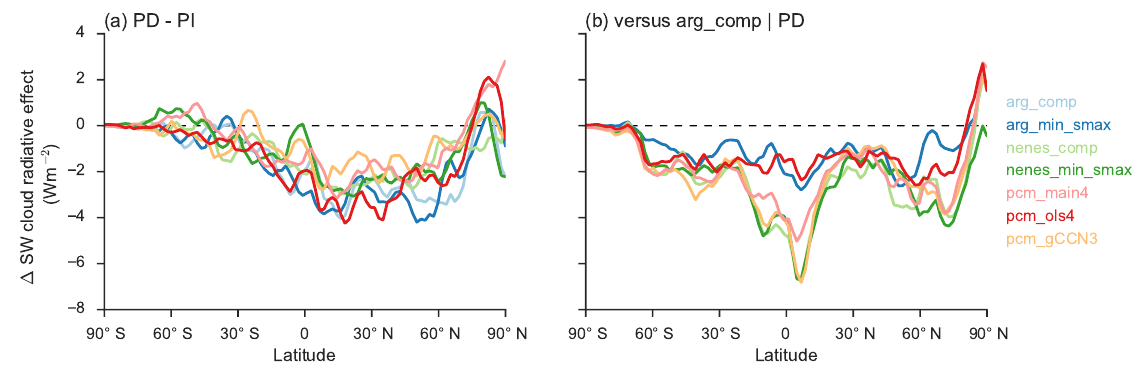
Figure 7. Difference in SW CRE between preindustrial and present-day emissions scenarios (a) and relative to the arg_comp simulation for present-day emissions (b)